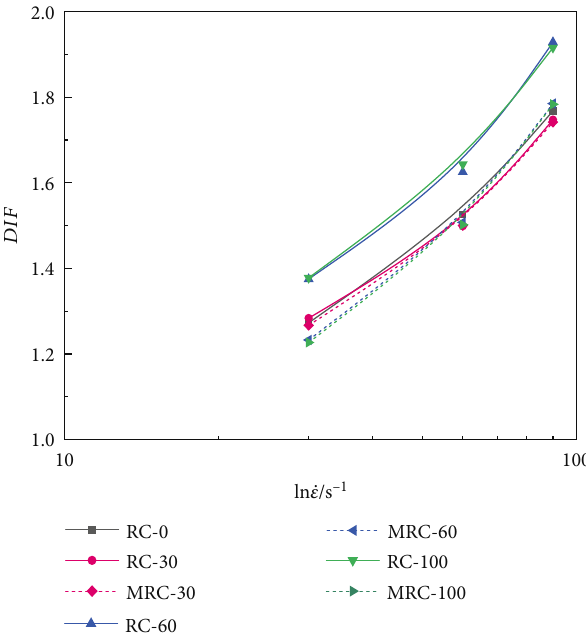
Figure 7: Relationship between the DIF and natural logarithm of the strain